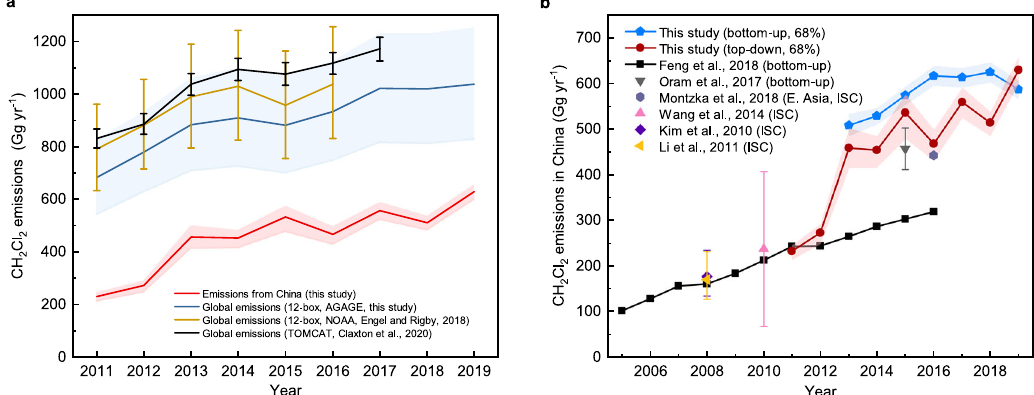
Fig. 2 Global emissions and emissions from China. a Derived global emissions of CH 2 Cl 2 in 2011 – 2019 and uncertainties (blue line and shading), and emissions from China (top-down, inversion based) and uncertainties (red line and shading). Global emissions derived using the 12-box model with NOAA data 1 (yellow line), and by TOMCAT (a global 3D model) with data from multiple sources 21 (black line), are shown in the plot for comparison. All uncertainties are the 68% interval. b Comparison of top-down emissions from China derived in this study (red line and shading) to previous bottom-up (inventory based) time series 17 (time period overlap 2011 – 2016, black line), and other estimates for speci fi c years 4,29,68 – 70 . The result from Montzka et al. 29 is the regional CH 2 Cl 2 emissions for East Asia. ISC means “ interspecies correlation ” method. A new bottom-up analysis for 2013 – 2019 (blue line and shading in b ) is estimated using newly obtained consumption and production data from CCAIA 33 (data shown in Supplementary Fig. 4a). Bottom-up results for individual sectors are shown in Supplementary Fig. 4b. All emissions results estimated in this study can be found in Supplementary Table